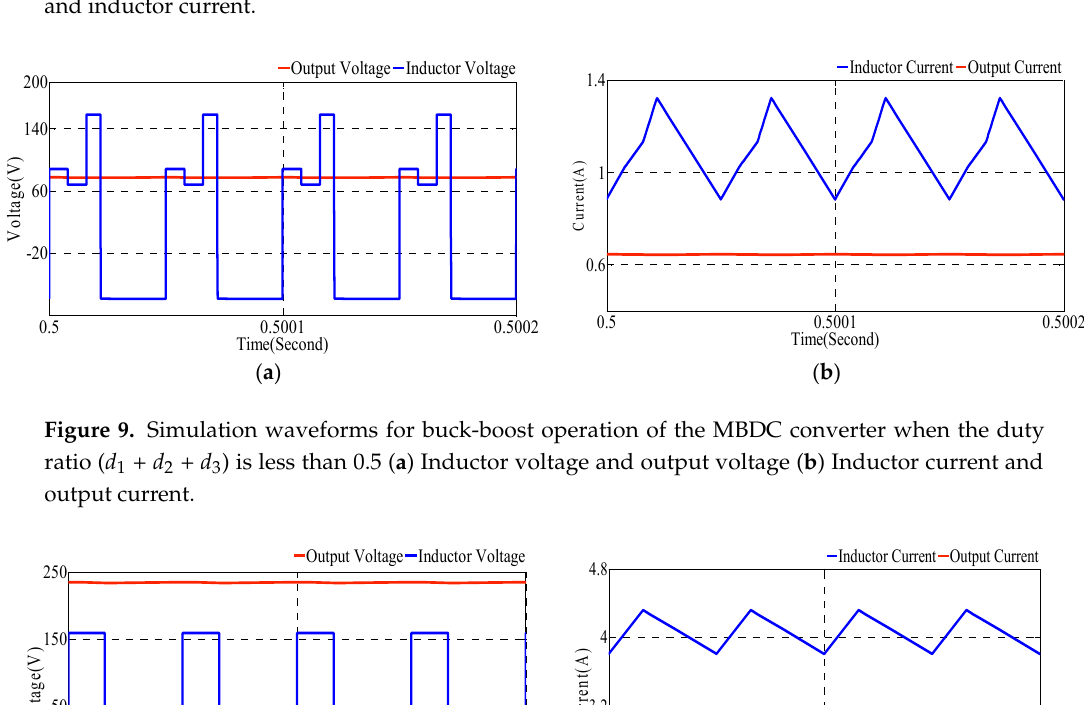
Figure 8. Simulation waveforms of the MBDC converter in buck-boost operation when the duty ratio ( i.e., d 1 + d 2 + d 3 ) is greater than 0.5: ( a ) Output voltage and inductor voltage; and ( b ) Output current and inductor current.